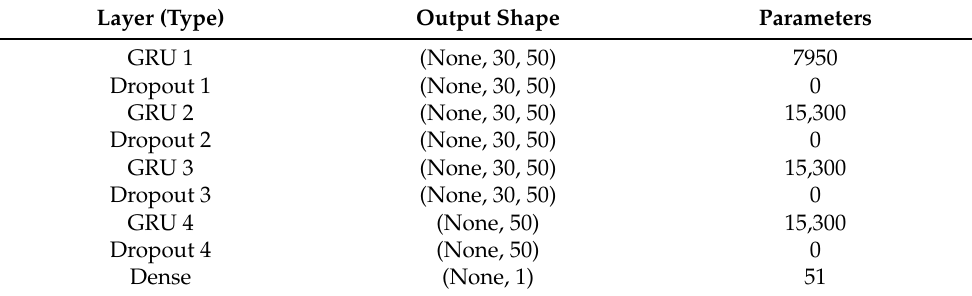
Table 6. The validation GRU model